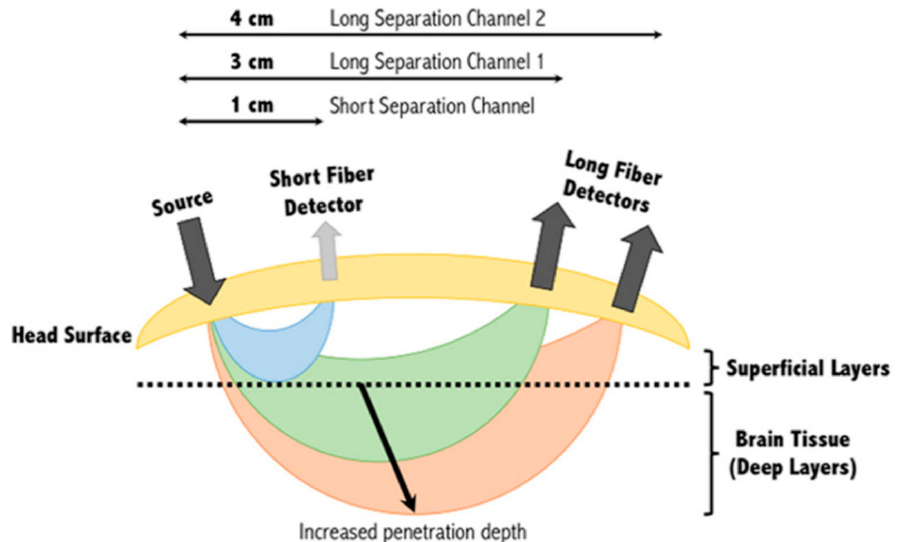
Figure 10. The image shows that as the distance between the emitter–detector pair grows, the deeper the signal penetrates. However, as you increase the depth imaged, the weaker the signal becomes; therefore, the optimal pair distance is around 3 cm. (Reprinted from